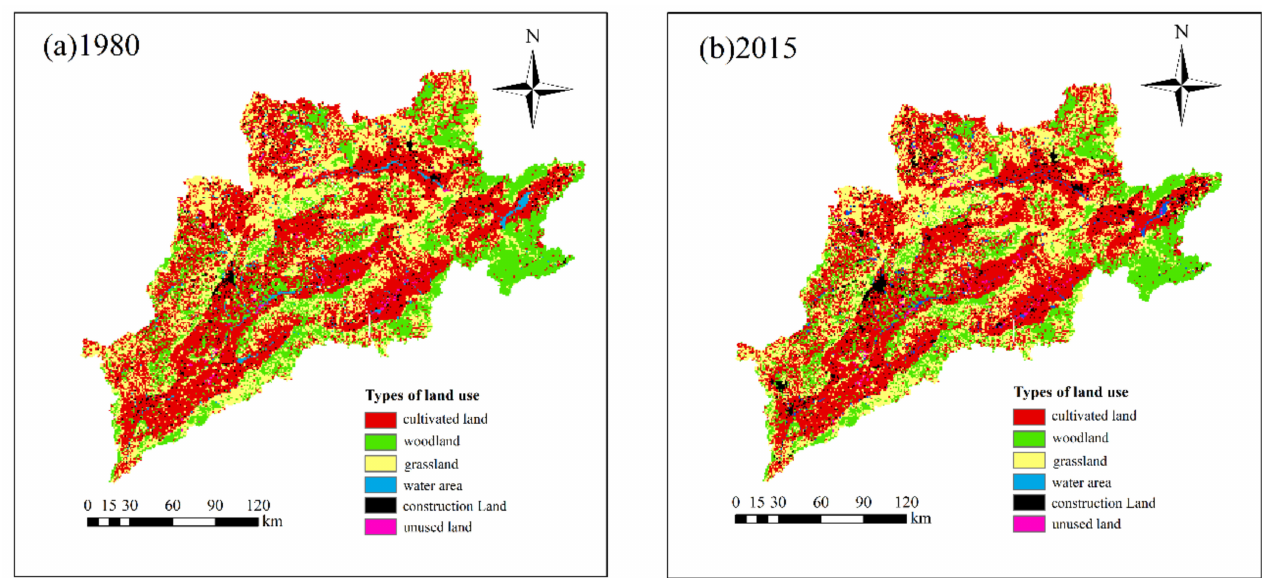
Figure 7. Land use types in the mountain area of Yongding River Basin. ( a ) Land use types in the mountain area of Yongding